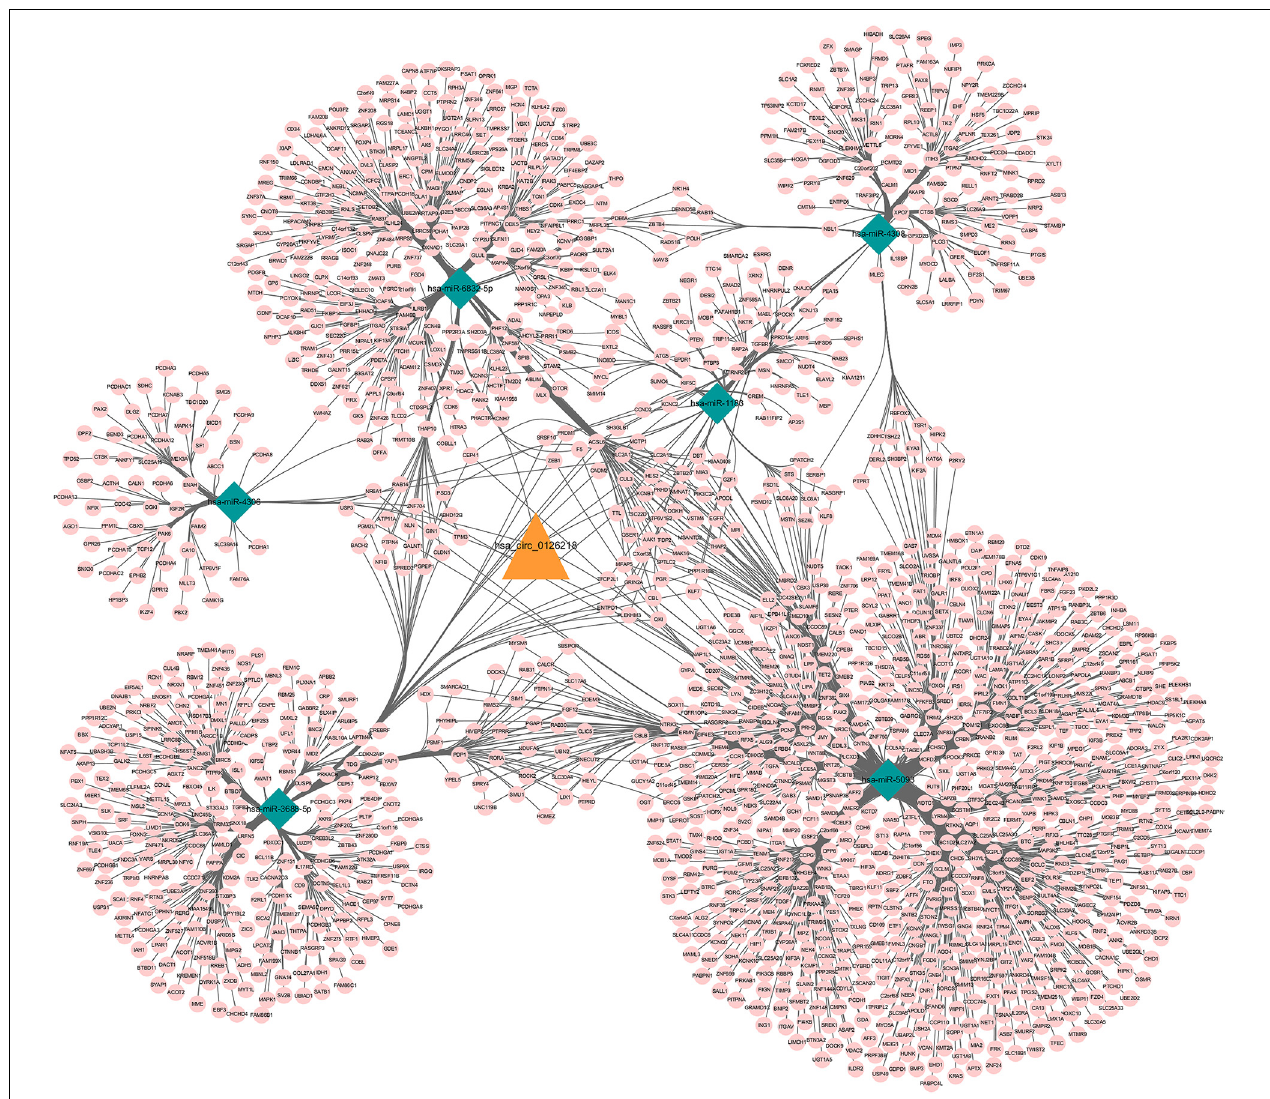
FIGURE 4 | ceRNA network of circRNA-miRNA-mRNA in female major depressive disorder. The network consisting of 1 circRNA node, 6 miRNA nodes, 1541mRNA nodes. Orange color indicates circRNA, Green color presents miRNA and Pink color illustrates mRNA. circRNA, circular RNA; miRNA, microRNA.